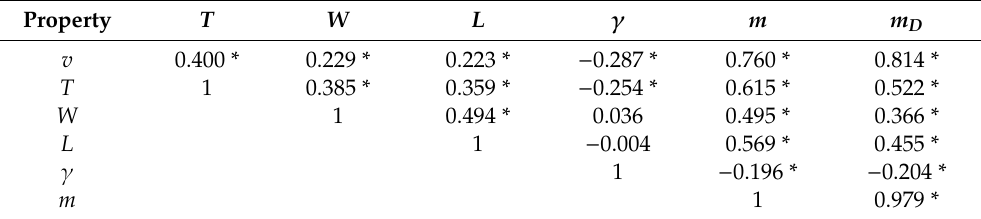
Table 2. Coe ffi cients of linear correlation between selected physical properties of black pine seeds. Property